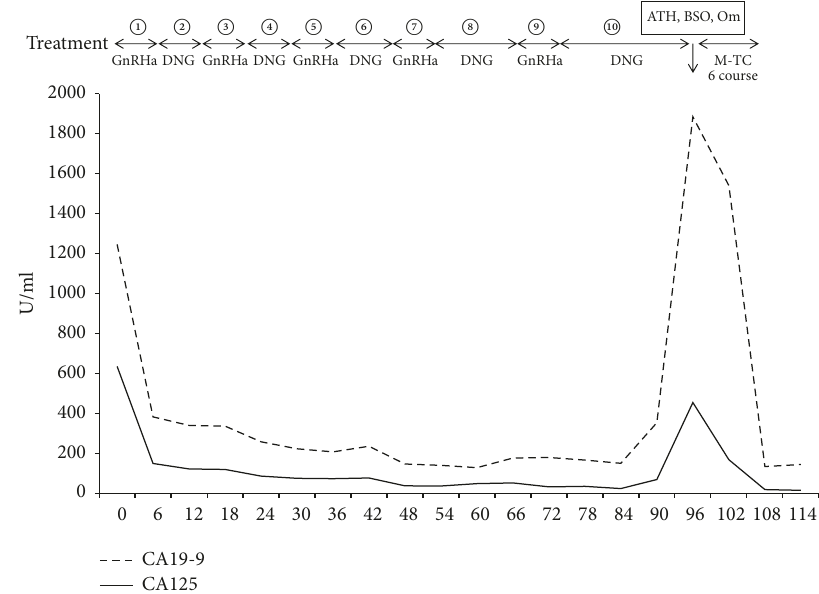
Figure 7: Clinical course of the patient. Increases in the level of the tumor markers, CA125 and CA19-9, are noted after six years of treatment. There was an observed decrease in the tumor markers following TC